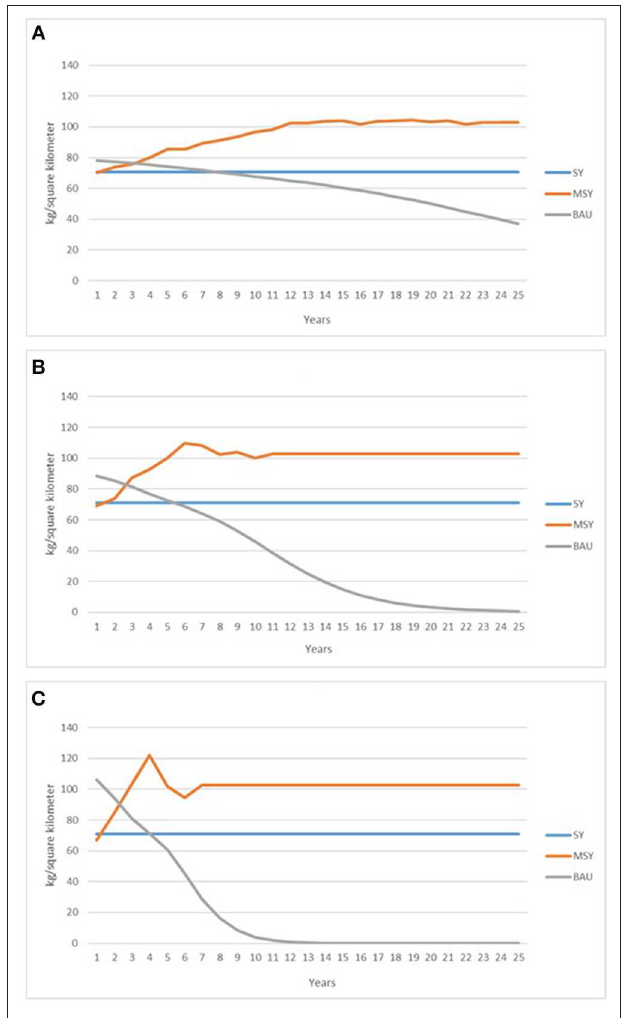
FIGURE 2 | Three comparisons of annual offtake over 25 years: sustainable yield (scenario 1); maximum sustainable yield (scenario 2); and business-as-usual (scenario 3). (A) (H) − 10% recovery to 0.5K then MSY compared to business-as-usual offtake 10% higher than sustainable yield; (B) (H) − 25% recovery to 0.5K then MSY compared to business-as-usual offtake 25% higher than sustainable yield (C) (H) − 50% recovery to 0.5K then MSY compared to business-as-usual offtake 50% higher than sustainable.